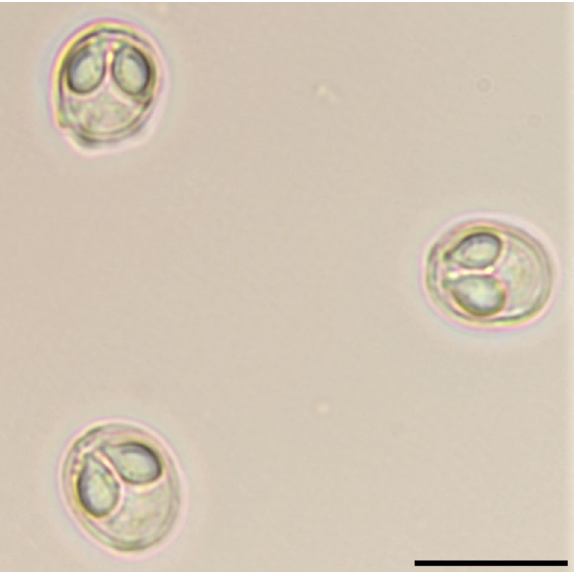
Figure 1. Myxobolus exiguus Thélohan, 1895 parasite of the visceral peritoneum and gall bladder of Chelon ramada (frontal view). Scale bar: 10